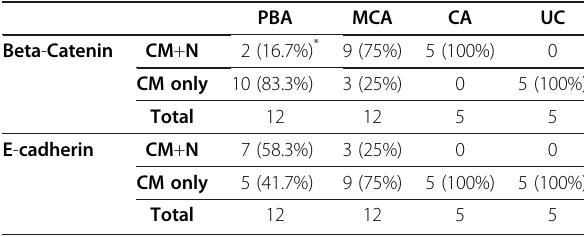
immunostaining of primary bladder adenocarcinoma, metastatic and primary colorectal adenocarcinoma and urothelial carcinoma